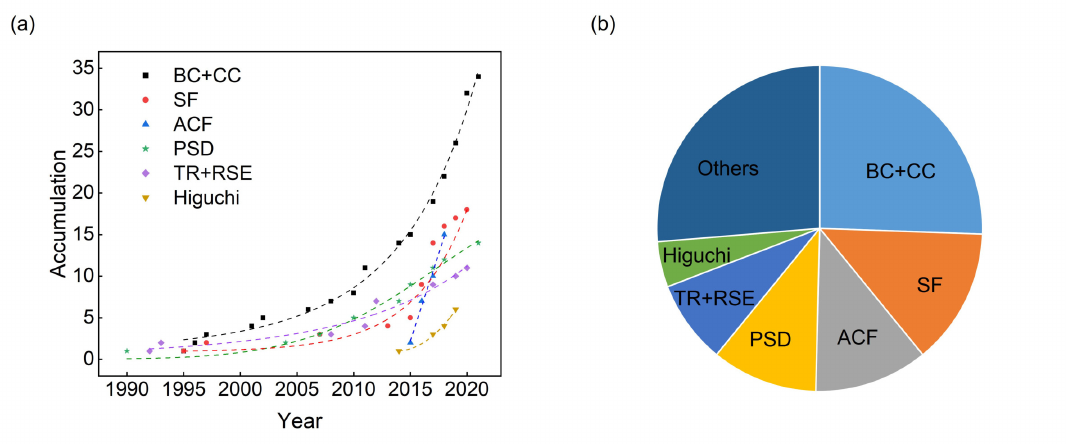
Figure 8. Application status of various fractal calculating methods on the film analysis published in the during literature(1990–2021). ( a ) trends of accumulative count, ( b ) usage ratio. Category “Other” incorporates some less frequently used methods, the specific content of which could be referred to Appendix A.